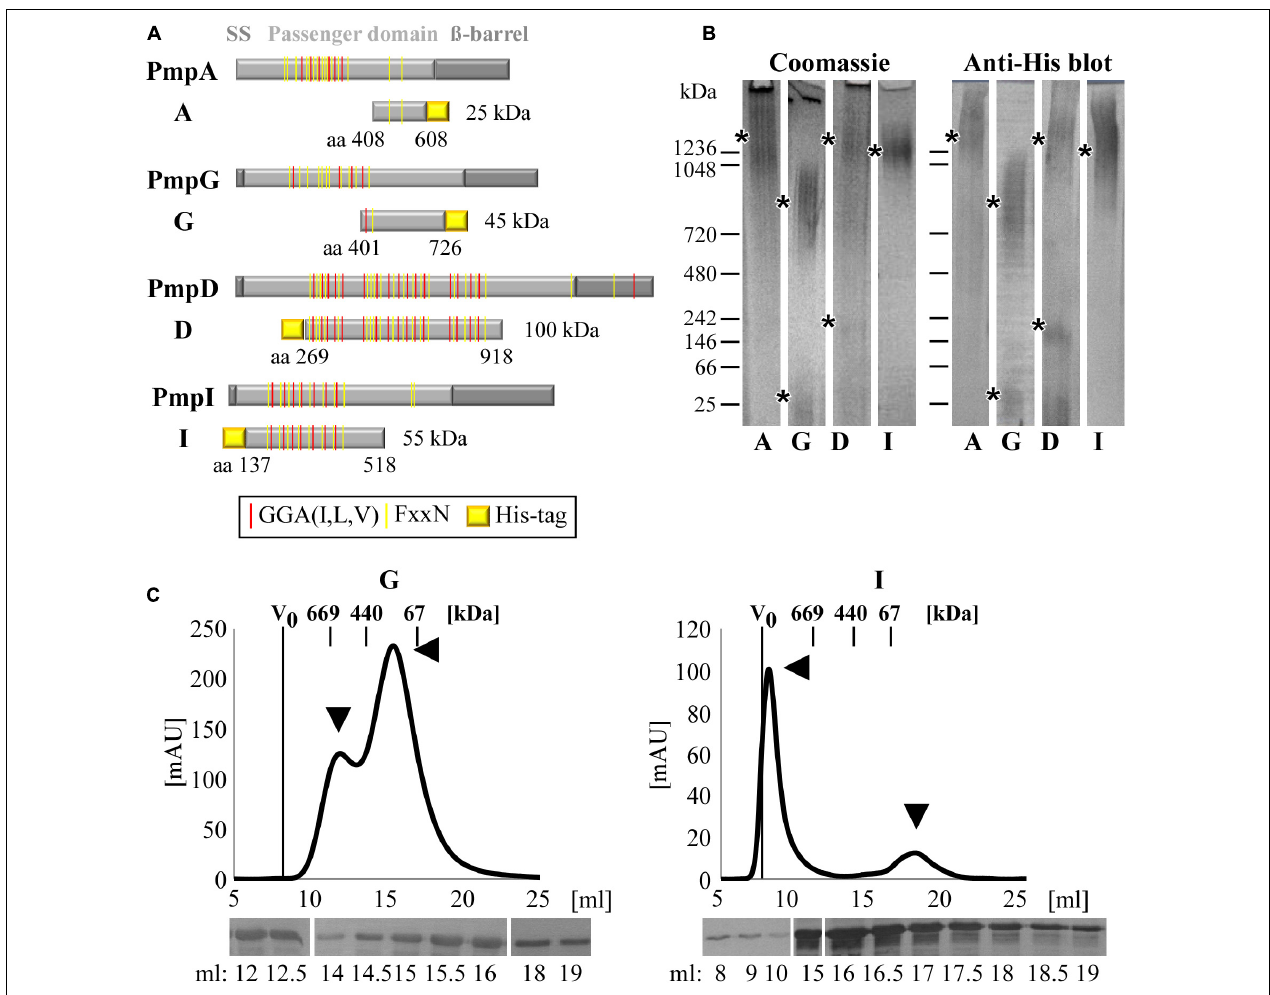
FIGURE 1 | C. trachomatis Pmps form homomeric high-molecular-weight (hMW) complexes. (A) Schematic representation of C. trachomatis Pmps A, G, D, and I. Gray boxes indicate the characteristic autotransporter structure of Pmps, with the N-terminal signal sequence (SS), the central passenger domain (PD) and the C-terminal ß-barrel. Red and yellow lines in the PD indicate the GGA(I,L,V) and FxxN repeated motifs. The protein fragments analyzed in this study are indicated below the respective proteins with their amino acid positions and carry a His-tag. (B) Coomassie-stained and anti-His immunoblot of Blue Native-PAGE (BN) of renatured Pmp fragments (A, G, D, and I) (1 µ g). Asterisks indicate the main bands. BN bands are cut for clarity purposes, original uncut pictures are shown in Supplementary Figure 6 . Images are representative of three separate experiments. (C) Size exclusion chromatography (SEC) curves of motif-poor PmpG and motif-rich PmpI, obtained with Superose6 columns. The void volume (V 0 ) is indicated. Elution volumes of globular standard proteins are indicated by short vertical lines. Arrowheads indicate relevant peaks. Anti-His immunoblots of relevant SEC fractions are shown at the